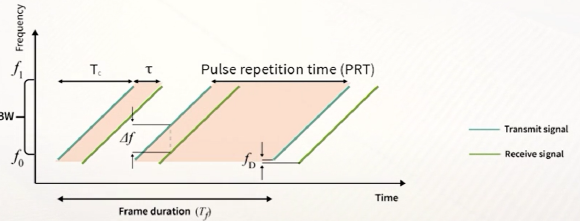
Figure 4. Visualization of the relation between transmitted and received waves. Source: